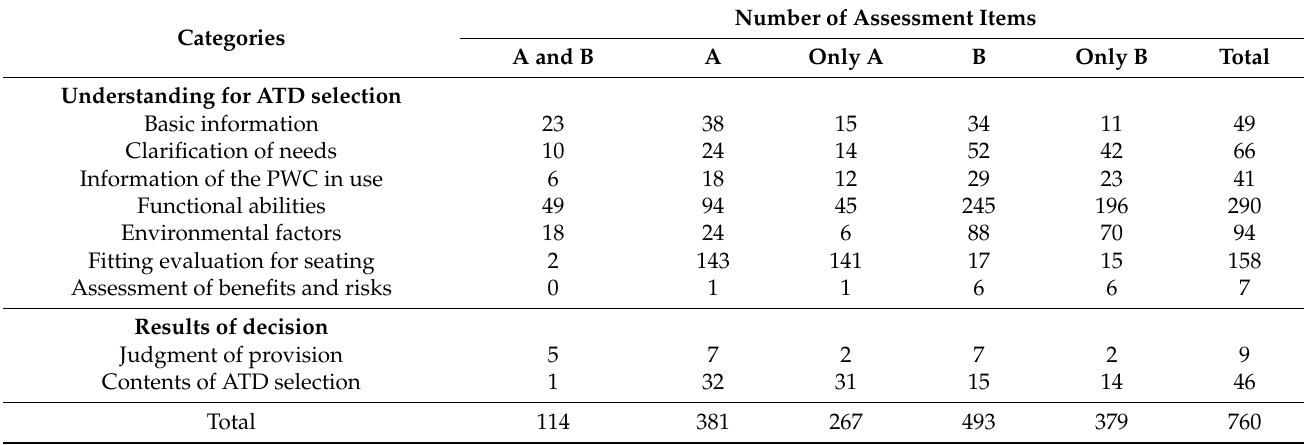
Table 1. Identified perspective categories and number of assessment items.